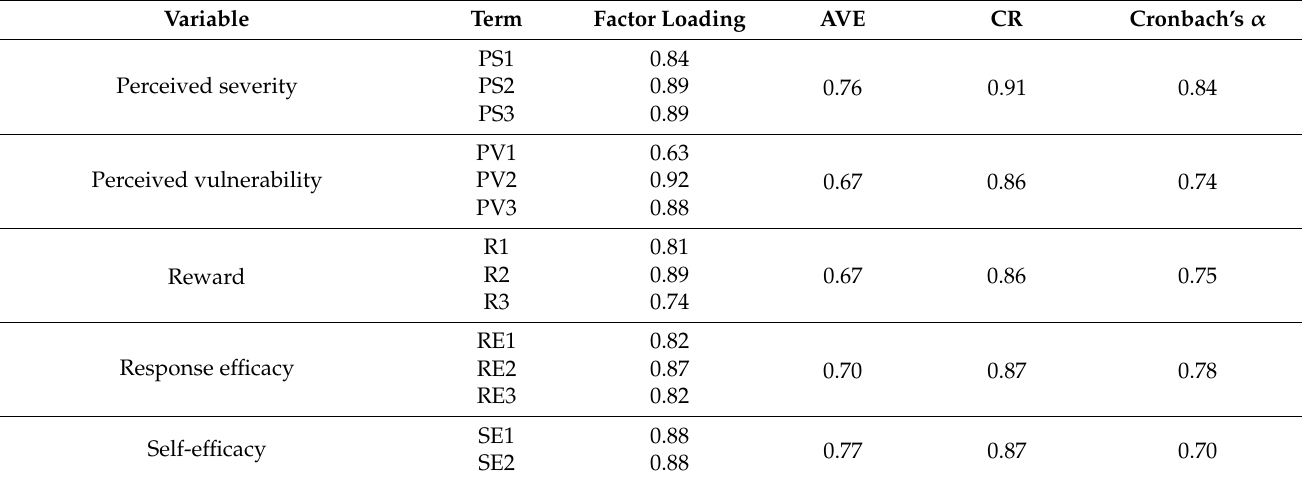
Table 2. Measurement scales and evaluation indicators for reliability and